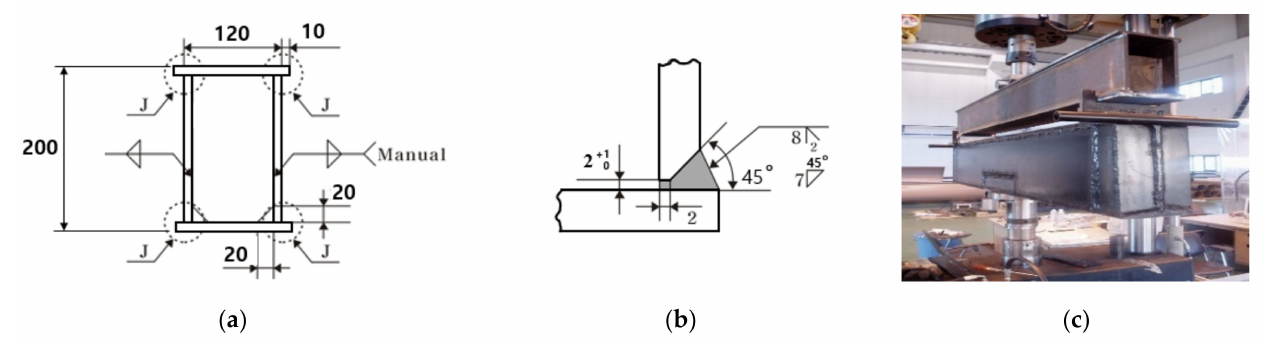
Figure 6. Configuration of the real-size beam and fatigue test setup. ( a ) Side view of the box-shaped beam; ( b ) detail ‘J’; ( c ) setup for three-point bending fatigue test